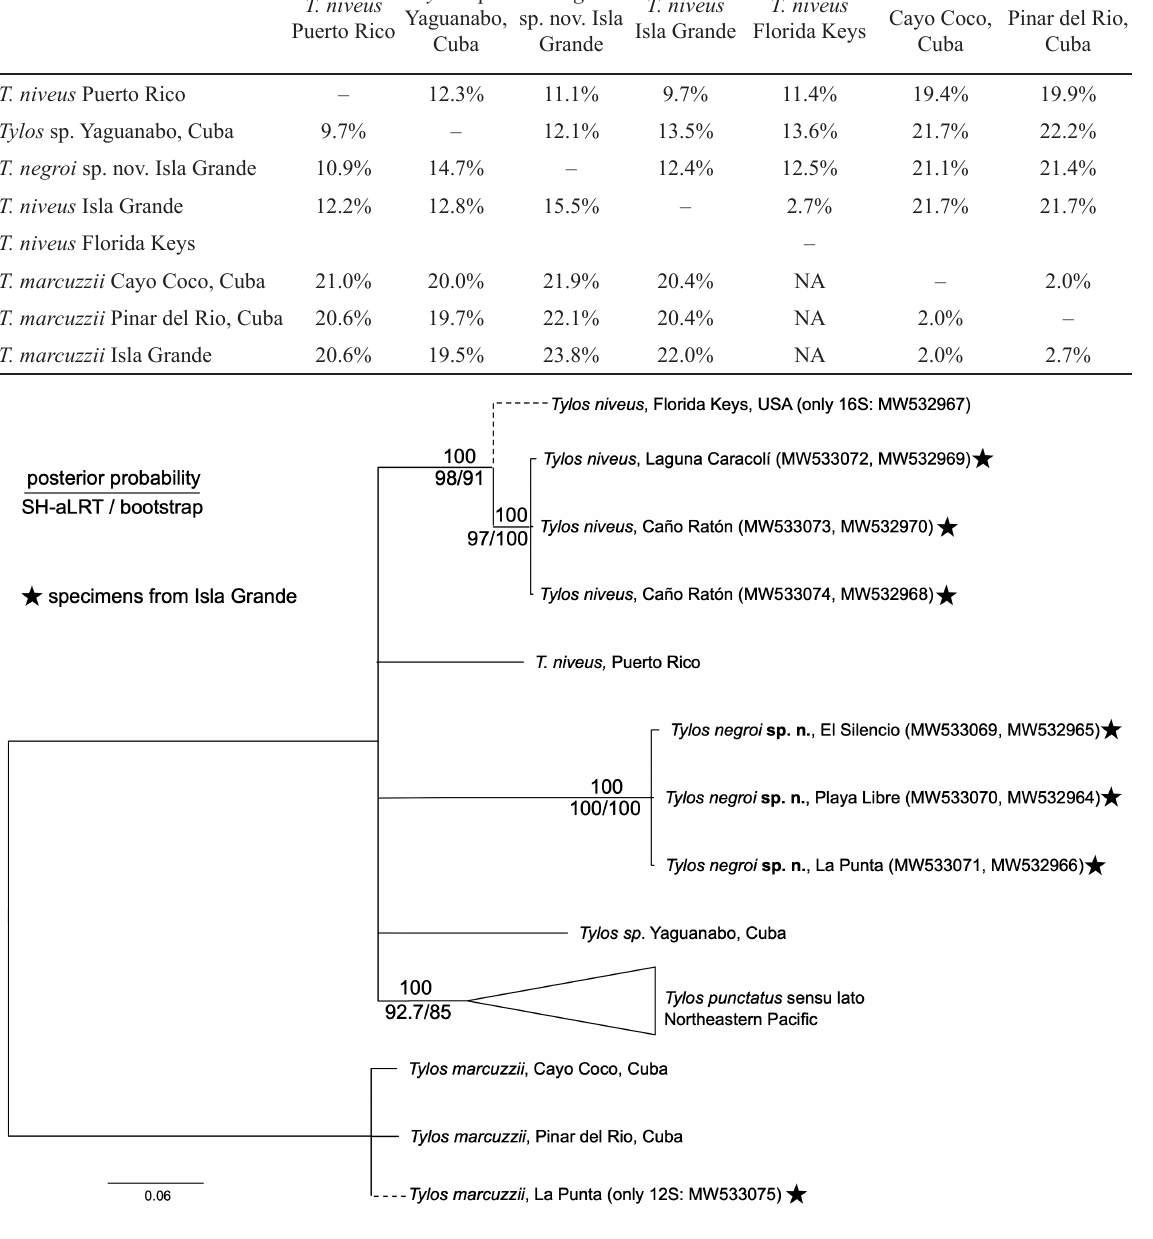
Fig. 18. Phylogenetic relationships among lineages of Tylos Audouin, 1826 from Isla Grande and their closest relatives. Majority rule consensus tree of the Bayesian posterior distribution (GTR+G+I model; 2 runs; 4 million generations; sampled every 1000; 10% burn-in), based on the dataset combining the 12S rDNA and 16S rDNA genes ( Supplementary file 3 ). Nodes with less than 70% support (posterior probability, bootstrap, and SH-aLRT) for any dataset have been collapsed. Dashed lines represent relationships redrawn based on single gene analyses ( Supplementary file 1 and Supplementary file 2 ). The split between the outgroup ( T. marcuzzii ) and the ingroup received 100% support in all analyses. Specimens from Isla Grande, Colombia are marked with a star. GenBank accession numbers for newly generated sequences are provided in parentheses.